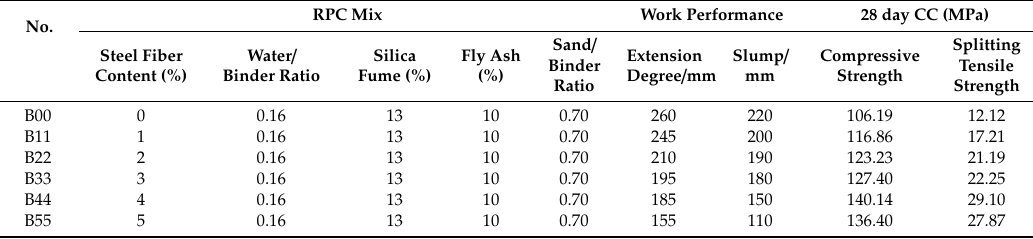
Table 13. Mechanical properties of steel fiber-reinforced RPC under compound curing conditions. RPC No.